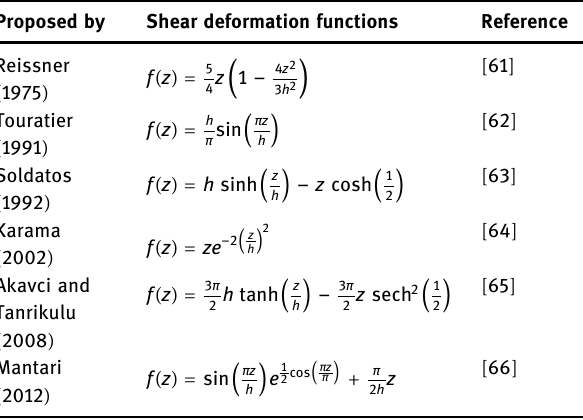
Table 1: Shear deformation functions corresponding to di ff erent higher order